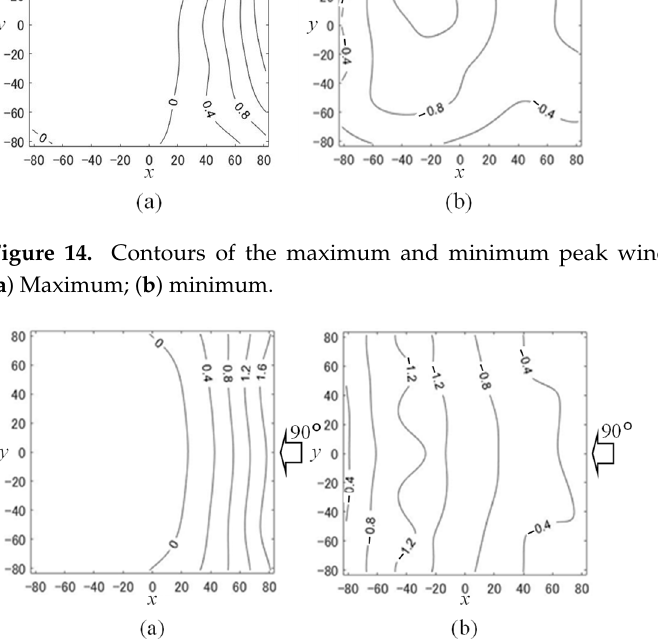
Figure 15. Contours of the maximum and minimum peak wind force coefficients at θ = 90°: ( a ) Maximum; ( b ) minimum.